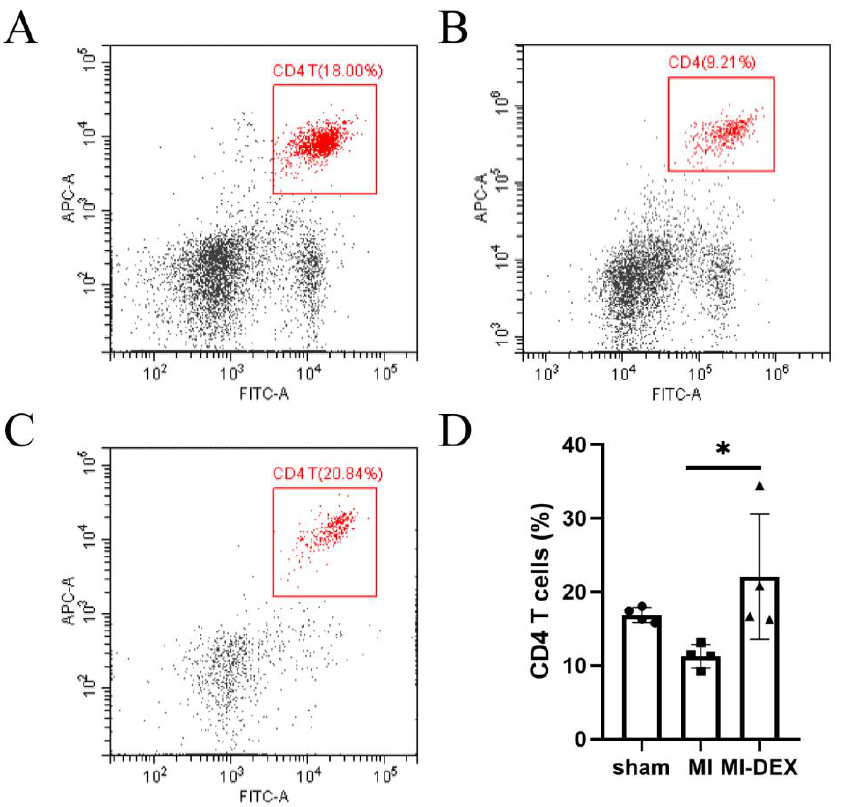
Figure 4. MI-DEXs raised the CD4 + T cell percentage in the spleen. Representative image of CD4 + T cells analyzed by flow cytometry in the sham group (A), MI group (B), and MI-DEX group (C); FITC-CD3; APC-CD4. Analysis of the proportions of CD45+, CD3+, and CD4+ T cells (D). n = 4, * p < 0.05, ** p < 0.01, *** p < 0.001.